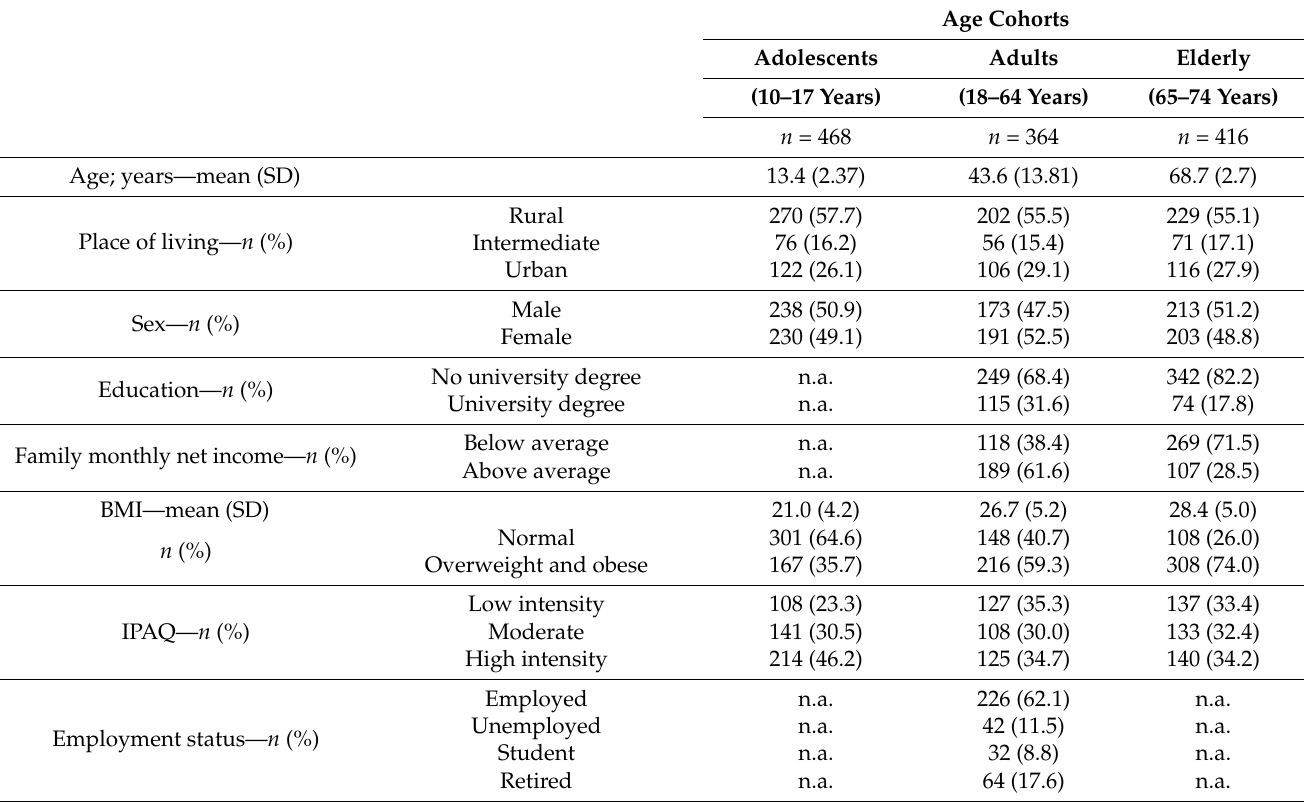
Table 1. Demographic and lifestyle characteristics of the study